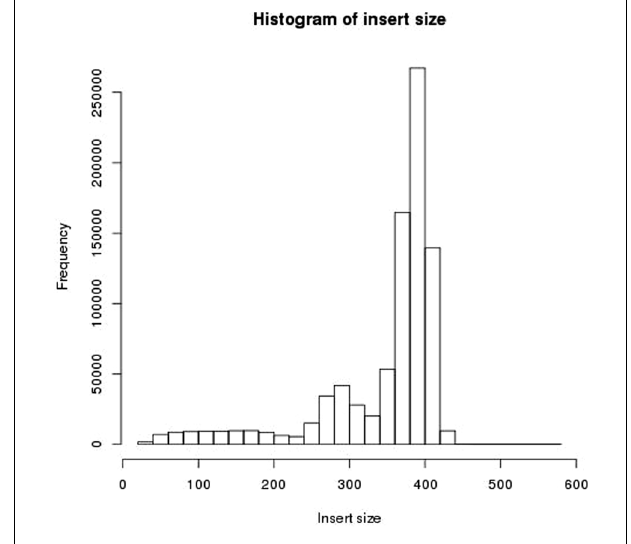
FIGURE 5 | Histogram of insert sizes of read pairs for a single library in this dataset.